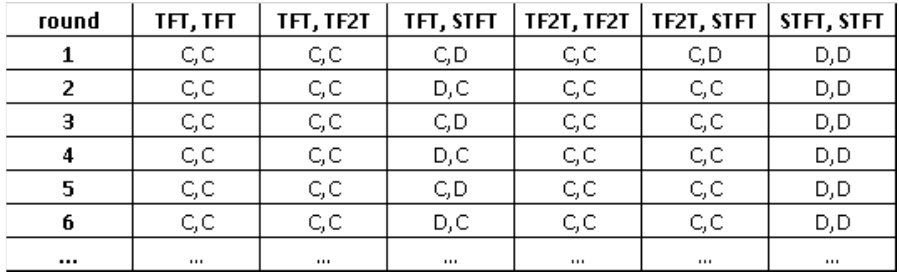
Patterns of interactions for every possible pair of strategies in an exemplary population consisting of TFT, TF2T and